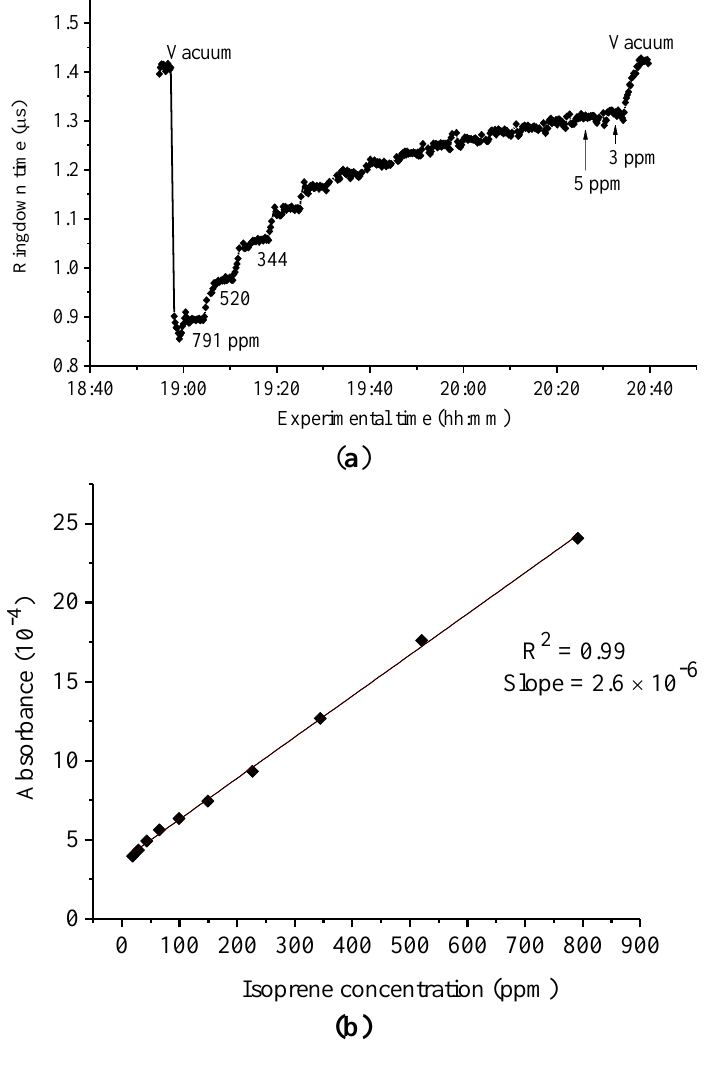
Figure 3. ( a ) Ringdown absorption graph for isoprene at 266 nm ( b ) Corresponding curve of the absorbance versus